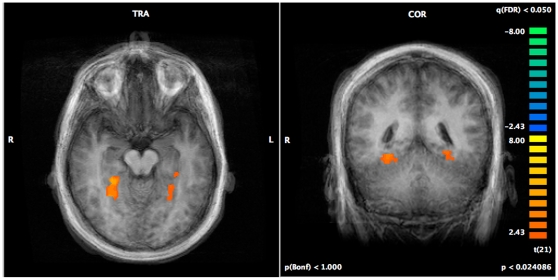
Fusiform activation during backward masking trials – between group comparison.